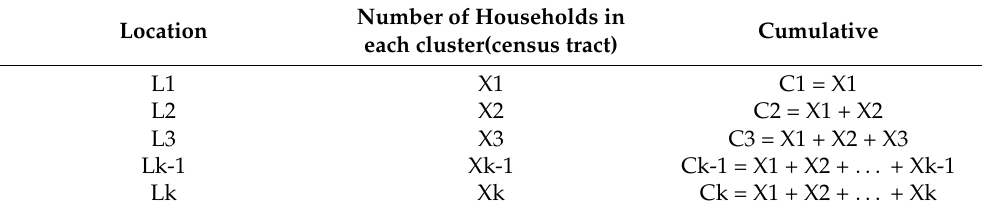
Table 1. The PPS sampling algorithm for selecting population locations. Number of Households in Location each cluster(census tract)